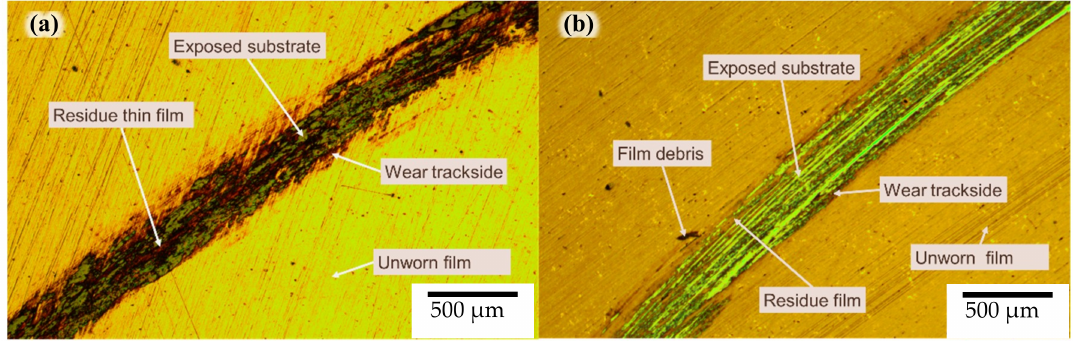
Figure 5. Optical micrograph of wear tracks of TiN coatings deposited by ( a ) HiPIMS and ( b ) DCMS. The ball-on-disc abrasive test was conducted under room temperature condition with a 100Cr6 steel